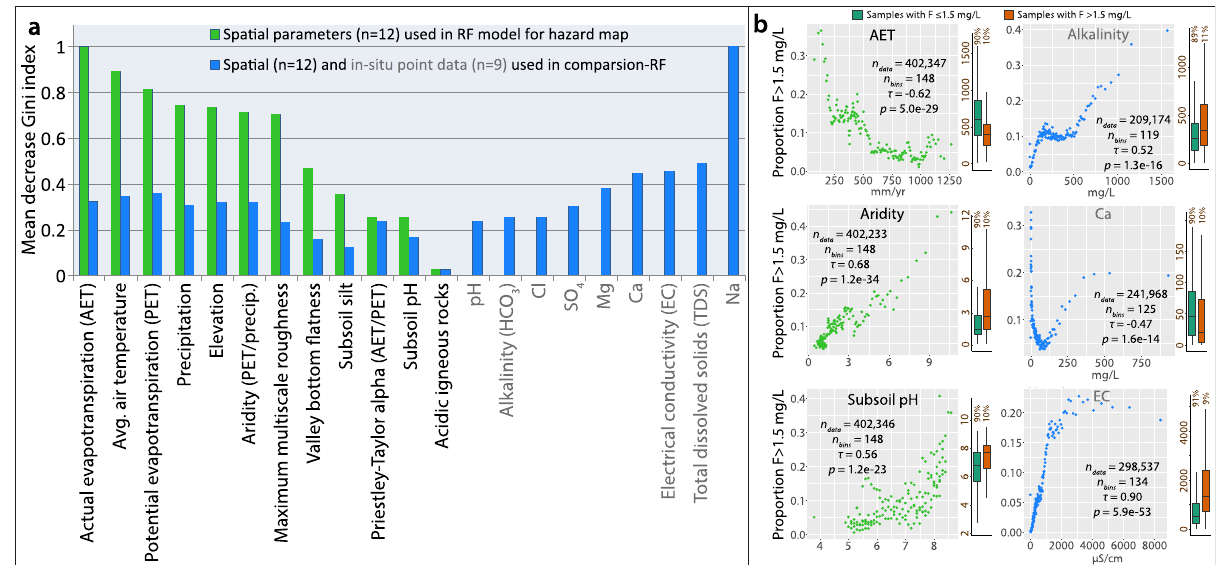
Fig. 2 Environmental and hydrochemical conditions related to high fl uoride concentrations in groundwater. a Importance of the predictor variables in modeling in terms of mean standardized decrease of the Gini index, which measures classi fi cation impurity such that a reduction represents improved classi fi cation. The importance of the 12 variables of the fi nal (geospatial) model (Fig. 1) is shown in green. For comparison, the importance of the combined geospatial/in-situ groundwater variables in the mixed (non-geospatial) model is shown in blue, for which it is not possible to generate a prediction map. b Correlation between selected variables and the proportion of groundwater fl uoride measurements greater than 1.5 mg/L as histograms (see “ Methods ” ). The plots of actual evapotranspiration, aridity, and subsoil pH are taken from the model using only geospatial parameters. The number of data points, number of bins (points), Kendall rank correlation ( τ ), and associated p -value ( p ) are indicated. The vertical box plots indicate the distribution of each parameter associated with fl uoride concentrations ≤ 1.5 mg/L and >1.5 mg/L, with the central line representing the median, the hinges showing the 25th and 75th percentiles, and the whiskers extending up to 1.5 times the inter-quartile range. For ease of presentation, outliers are not